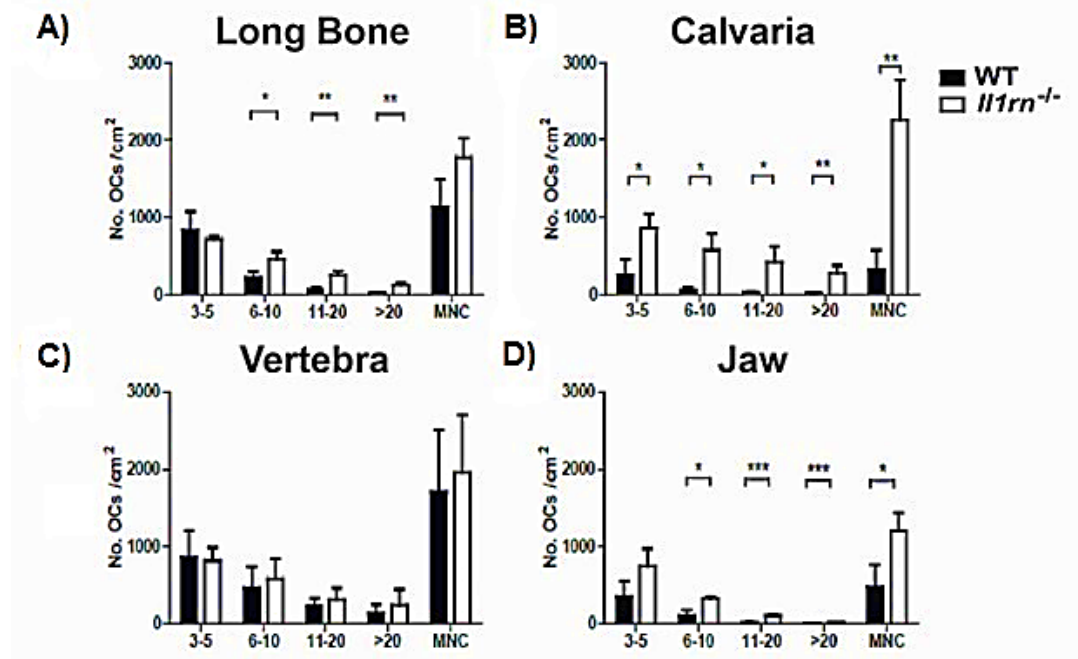
Figure 3. Increased number of osteoclasts generated from long bone, calvaria, and jaw but not vertebra marrow cells of Il1rn −/− mice. Bone marrow cells from long bone, calvaria, vertebra, and jaw were cultured with 30 ng/mL M-CSF and 20 ng/mL RANKL on bone slices for 6 days. Osteoclasts were stained for tartrate resistant acid phosphatase (TRAcP), counted, and categorized as 3-5 nuclei, 6-10 nuclei, 11-20 nuclei, and >20 nuclei. The number of osteoclasts (≥3 nuclei) was counted for long bone ( A ), calvaria ( B ), vertebra ( C ), and jaw ( D ) and compared between wild-type (WT) and Il1rn -/- mice. The total number of osteoclasts is shown as multinucleated cells (MNCs). Osteoclastogenesis was significantly higher in long bone, calvaria, and jaw of Il1rn −/− osteoclast precursors (OCPs) compared to WT OCPs. In contrast, WT and Il1rn −/− OCPs isolated from vertebrae formed a comparable number of osteoclasts ( n = 6 mice/group, * p < 0.05, ** p < 0.01, *** p < 0.001).